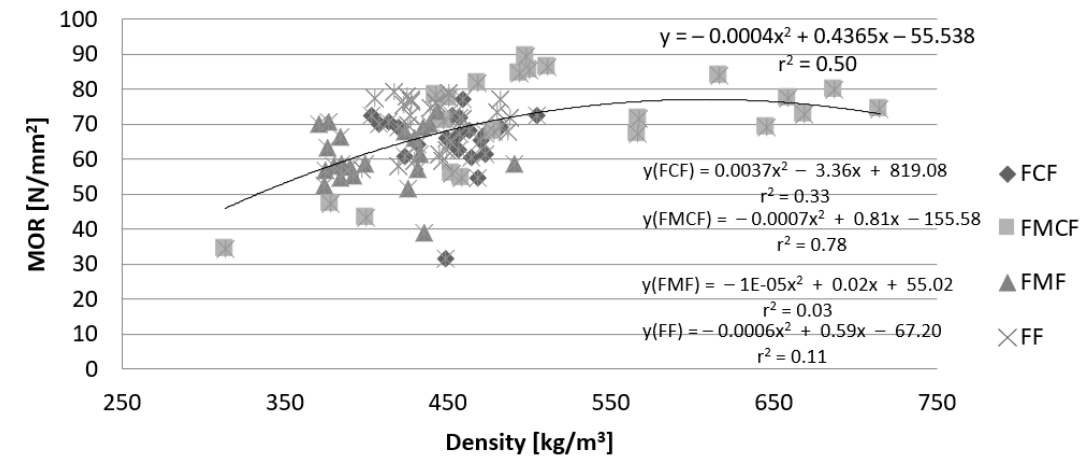
Figure 4. The average flexural strength of wood from various types of forest habitat (Source: Author’s original